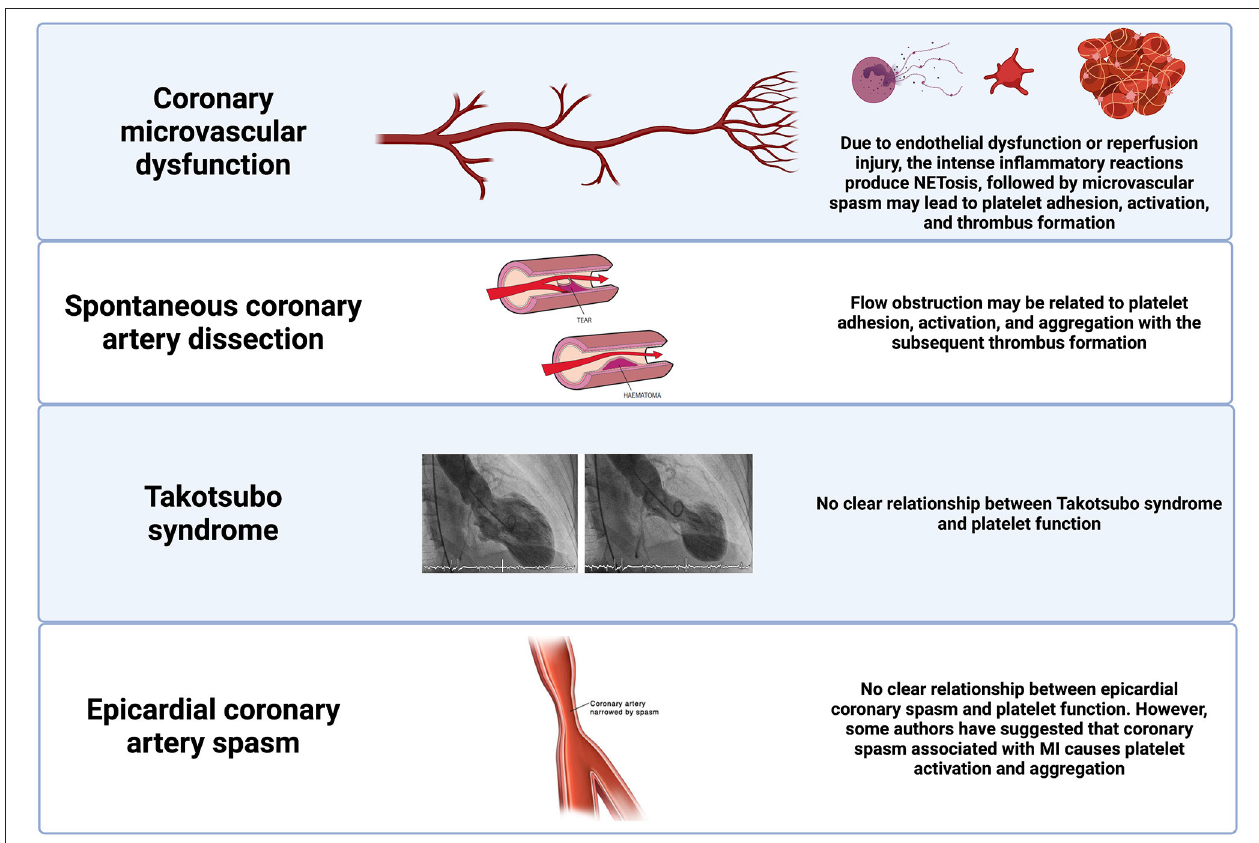
FIGURE 2 | Pathophysiological pathways of MINOCA in patients without coronary atherosclerotic disease. Potential pathophysiological pathways in selected non-atherosclerotic causes of MINOCA and their relationship with platelet function. MINOCA, myocardial infarction with non-obstructive coronary